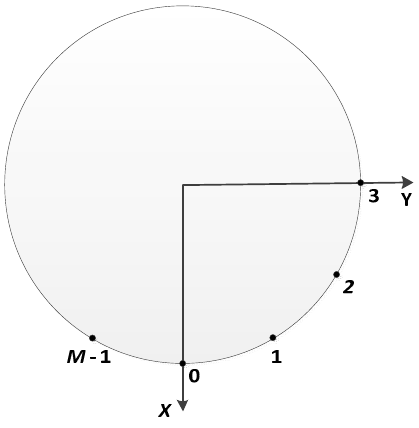
Figure 1. Array structure diagrammatic sketch.